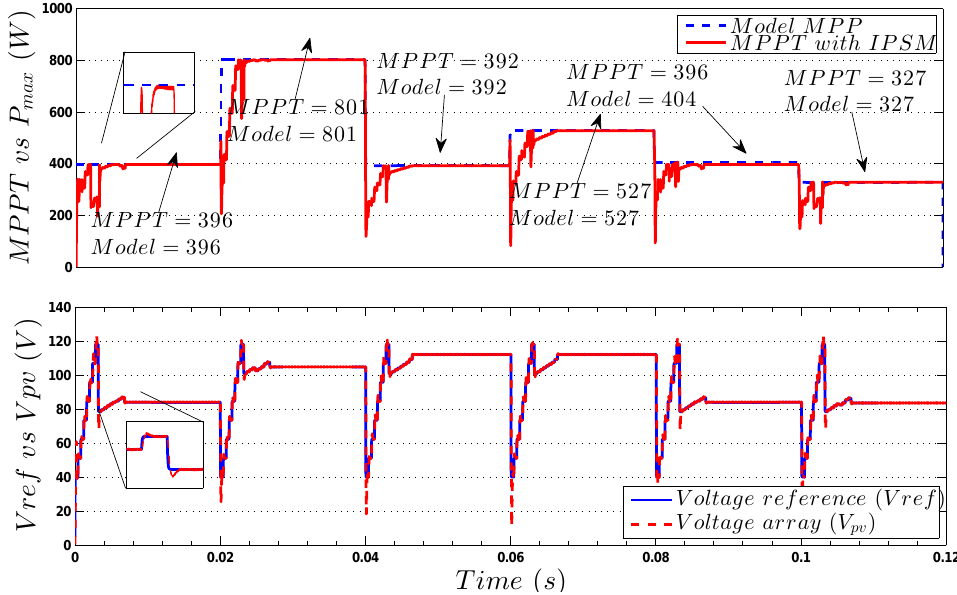
Figure 11. Simulation MPPT (maximum power point tracking algorithms) with multipeaks with 4 PV panel KC200GTO in series and changes in the irradiance ( G